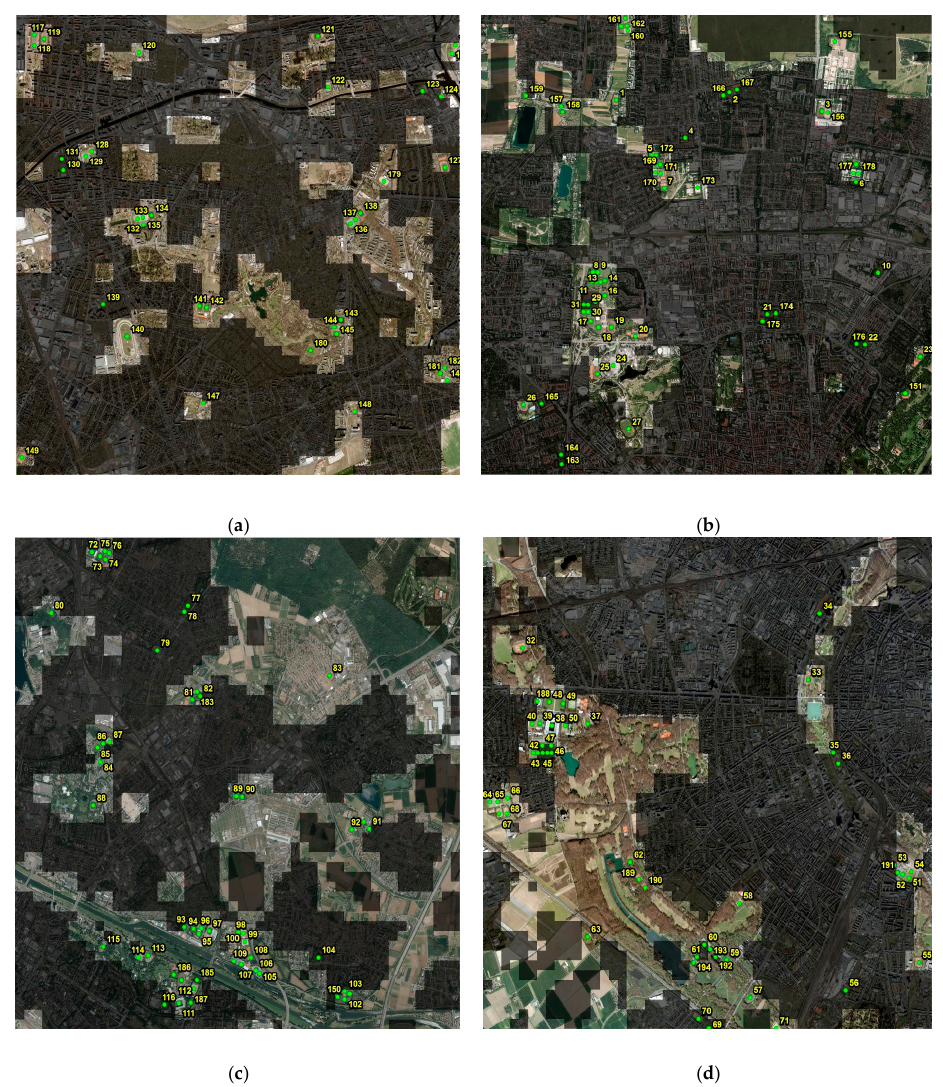
Figure 7. DLA-suggested areas where soccer fields existed and the actual ground truth (bright areas): ( a ) Berlin; ( b ) Munich; ( c ) Mannheim; ( d ) Cologne.